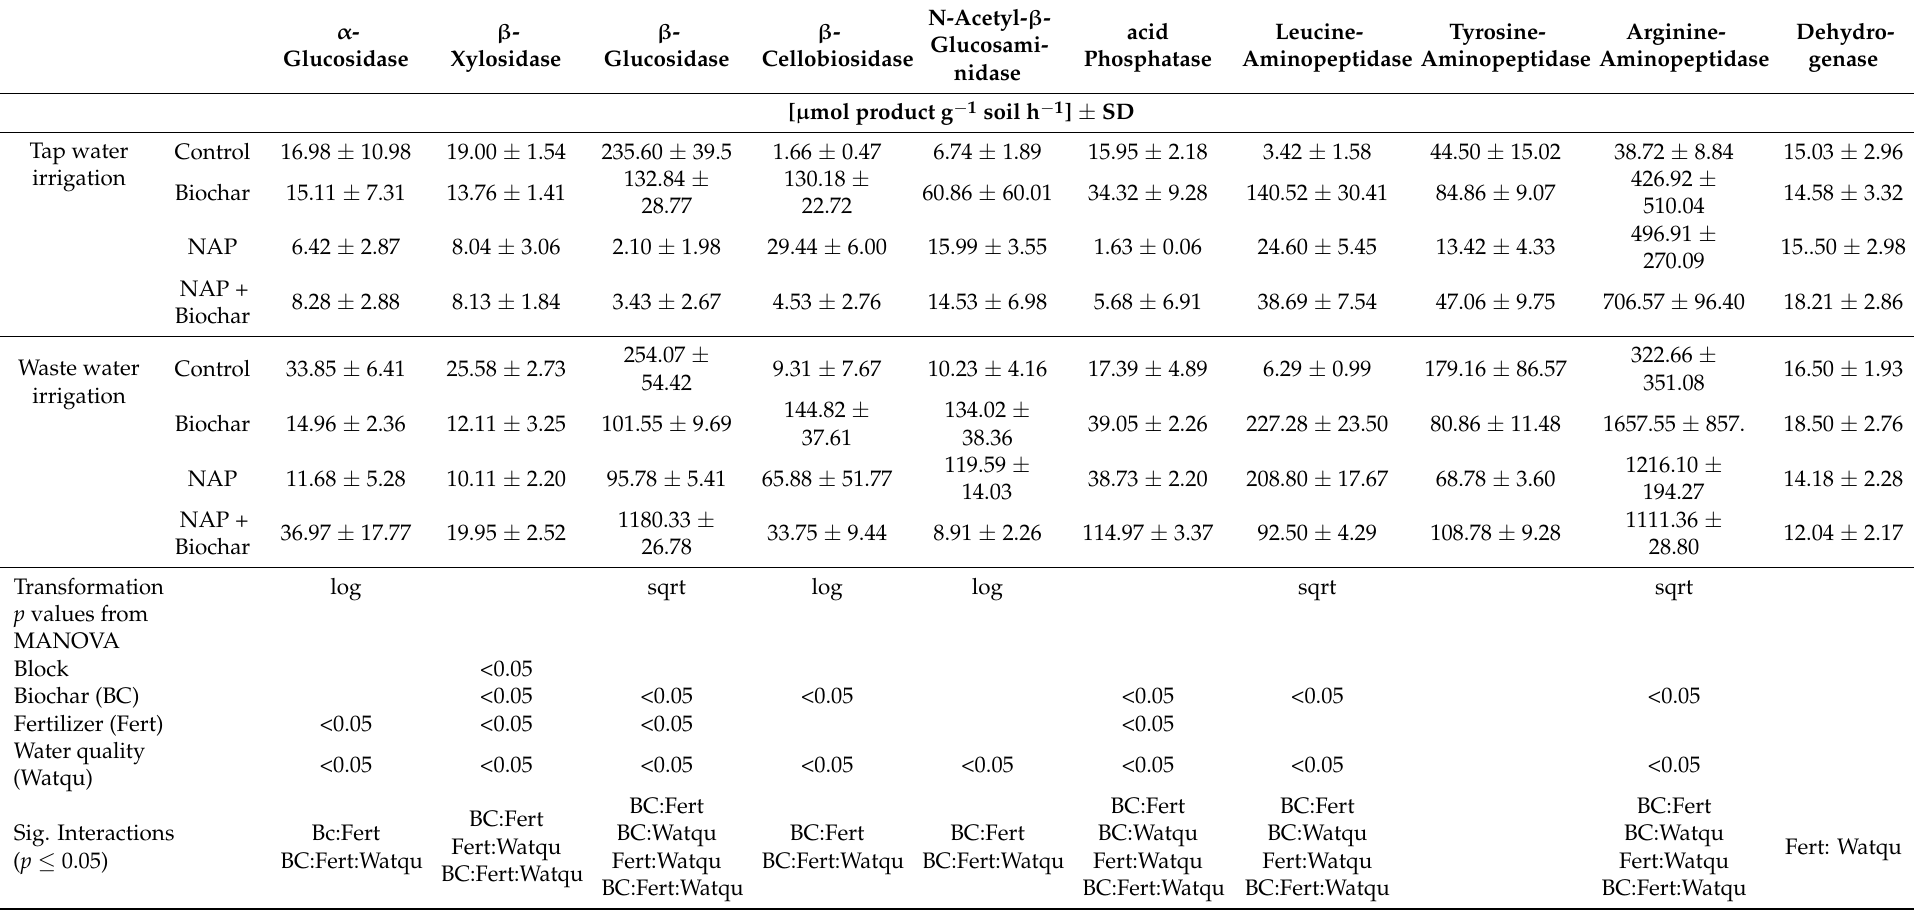
Table 3. Soil enzyme activities in tap or wastewater irrigated soils. Significant different of means and interactions are given as p -values of MANOVA ( p < 0.05). Values after ± sigh indicate standard deviation with, n = 4. Transformation applied after the Shapiro Wilk test are indicated for each parameter. Bc, Fert and Watqu in the table represents biochar, fertilizer and water quality